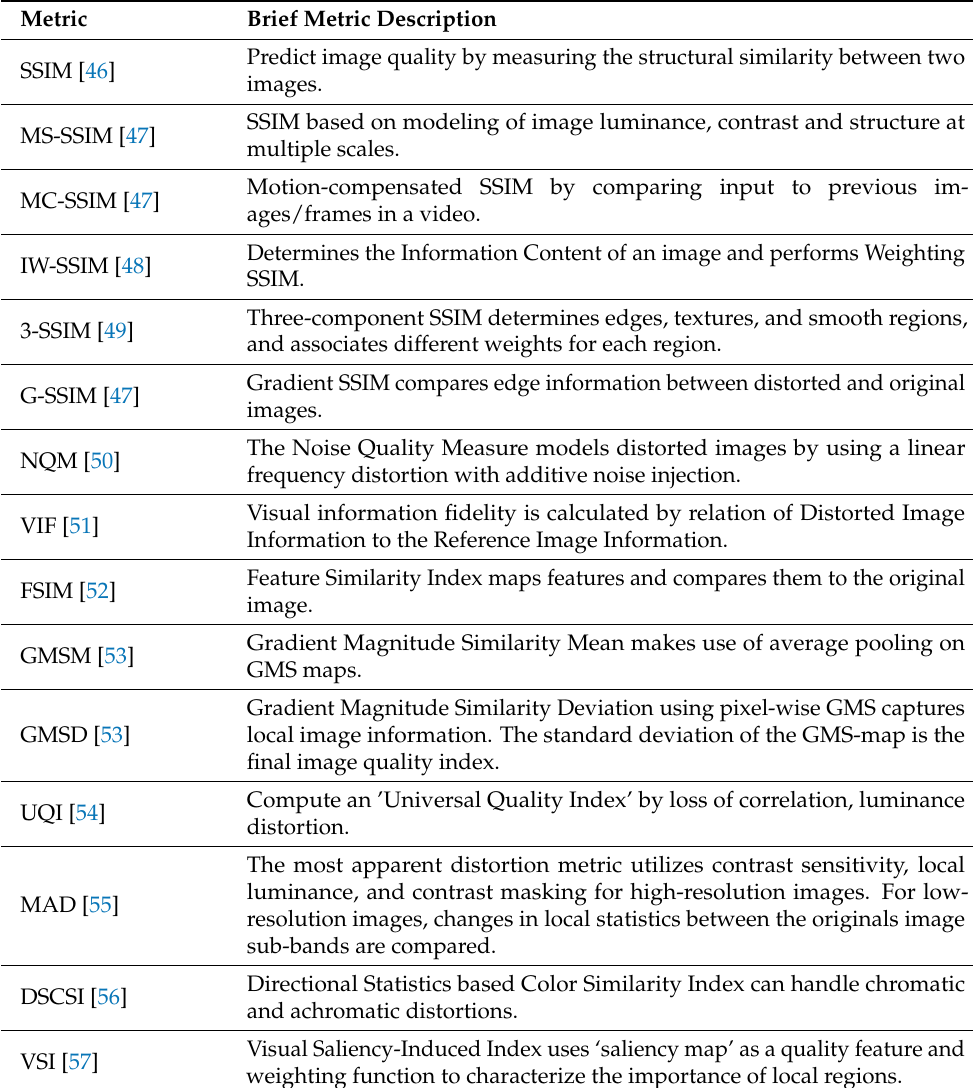
Table 1. Full-reference-based deterministic metrics for automated image quality assessment.